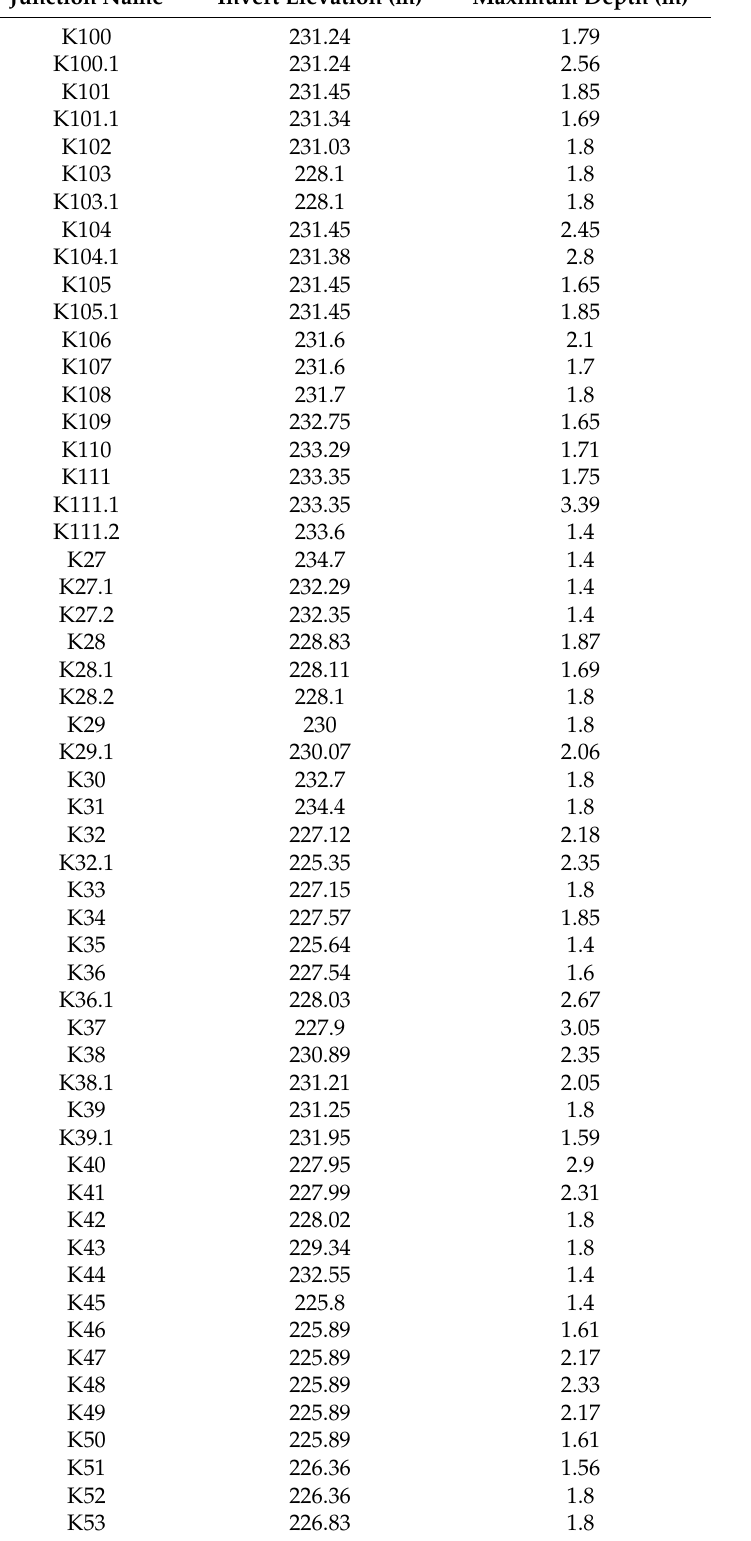
Table A2. Technical parameters of the